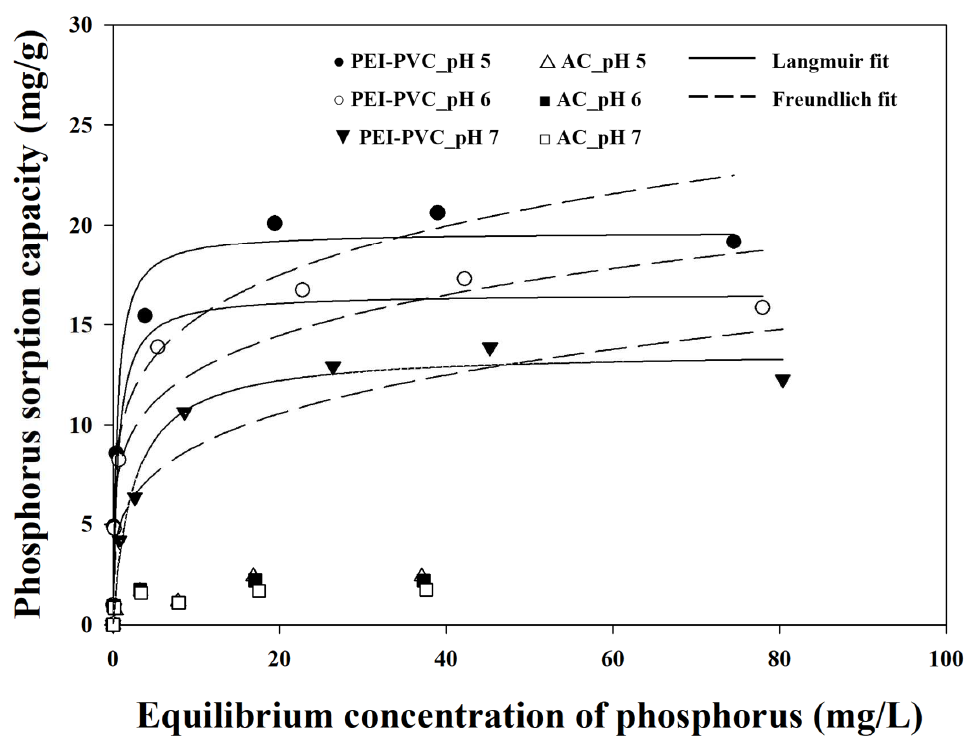
Figure 7. Isotherm results of PEI-PVC and activated charcoal for phosphorus adsorption at pH 5, 6, and 7. Table 3. Estimated isotherm parameters of PEI-PVC for phosphorus from Freundlich and Langmuir models.